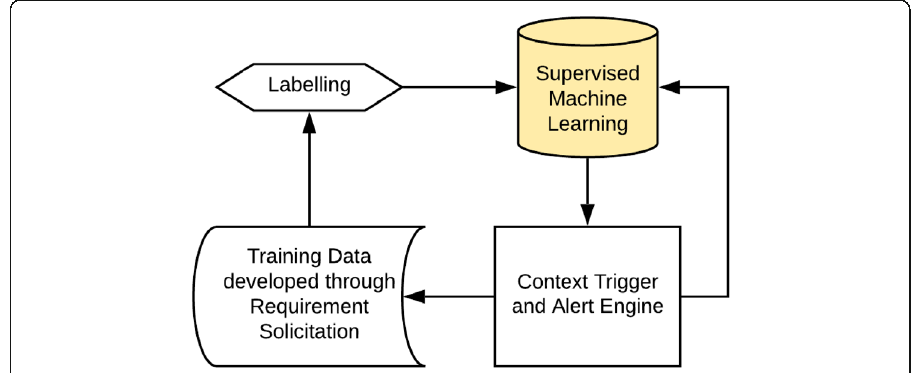
Fig. 8 How machine learning contributes to contextual negotiated policy